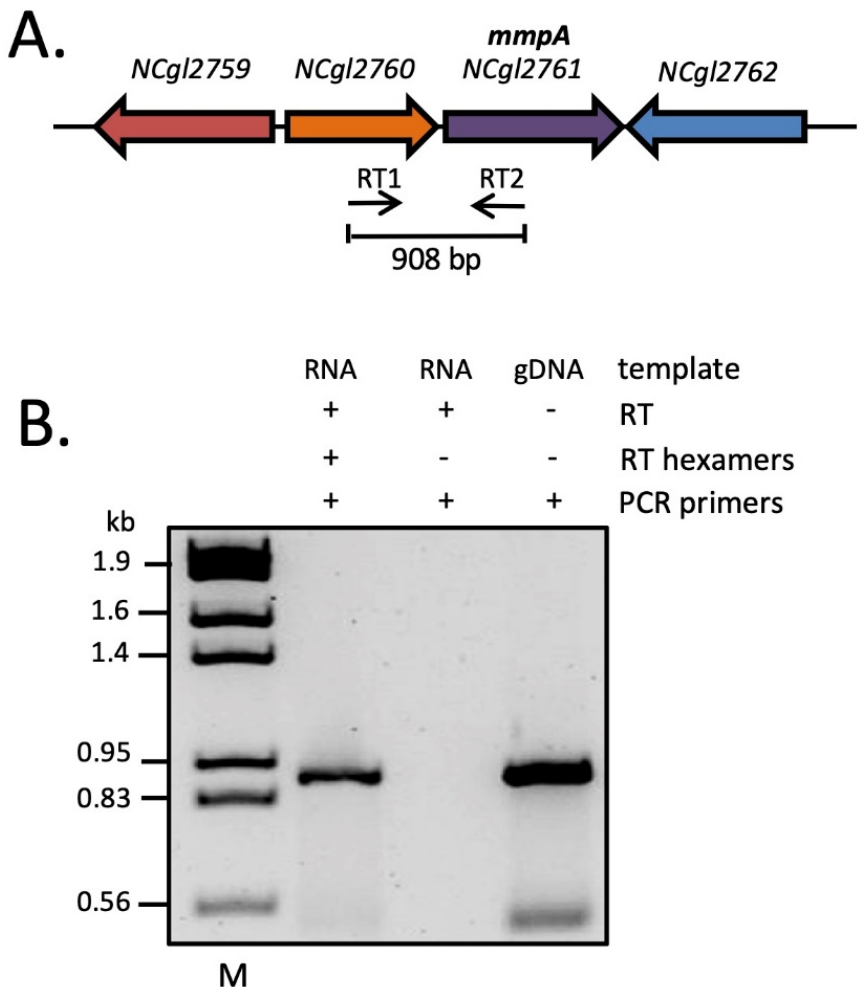
Figure 2. RT ‐ PCR analysis reveals co ‐ transcription of NCgl2760 and NCgl2761 . ( A ) The genetic locus with binding sites and orientations of the two RT-PCR primers within the two genes indicated by thin horizontal arrows. ( B ) Agarose gel electrophoresis of RT ‐ PCR reaction products. RNA was prepared from WT C. glutamicum and incubated with reverse transcriptase (RT) in the presence of random hexamers or in their absence (negative control). The samples were then subjected to a PCR using primers RT1 and RT2 to detect complementary DNA (cDNA) that spans both genes. Purified C. glutamicum genomic DNA (gDNA), PCR amplified using the same primer pair, was used as a positive control. M, λ HindIII/EcoRI DNA size markers (indicated in kb).